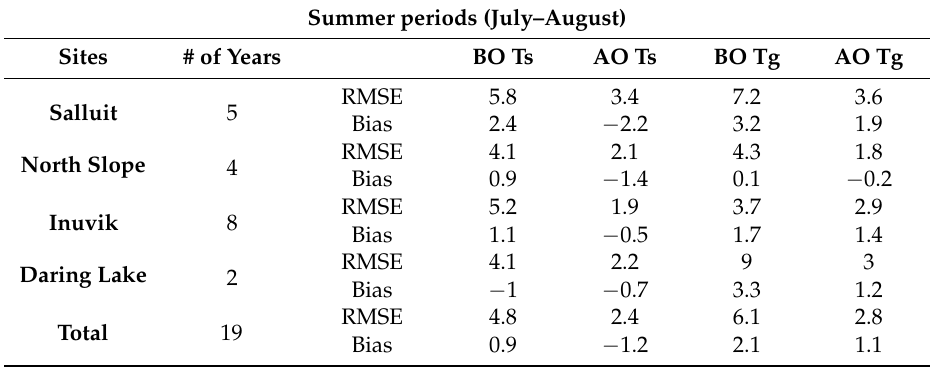
Figure 8. Results of air temperature and precipitation optimizations in Inuvik during summer (July and August, day/month) 2008. The top graph shows a comparison between measured (AMSR-E) and adjusted simulated (Canadian Land Surface Scheme (CLASS)) brightness temperatures at 19 V GHz for both orbits. The middle graph shows a comparison between measured (MODIS) and adjusted simulated (CLASS) surface temperatures. The bottom graph shows a comparison between measured (Station), simulated before optimization (CLASS BO), and simulated after optimization (CLASS AO) soil temperatures (Tg). Table 3. RMSE and Bias (in K) at the four tundra sites for the available summer time series for the surface temperature (Ts) and soil-temperature (Tg). BO and AO refer respectively to the values before and after optimization procedures (meteorological adjustment) (see definitions in Table 2).